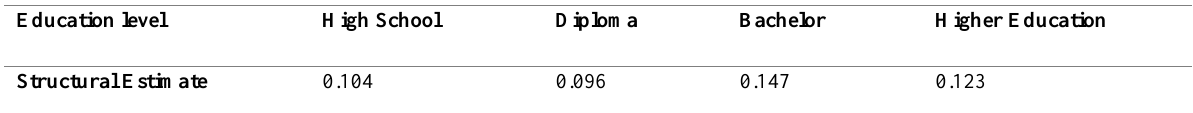
Table 10: Regression weights of the relationship among education level, return process experience post-purchase regret at